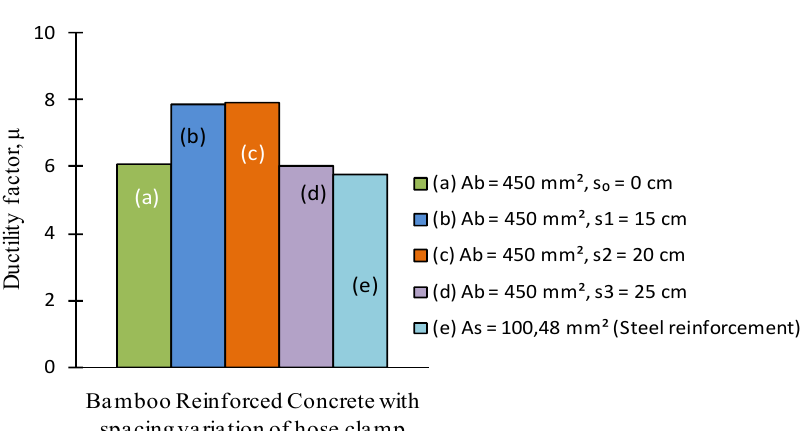
Figure 16. The difference in stiffness between the SRC beam, BRC beam, and BRC beam of ANN analysis result.